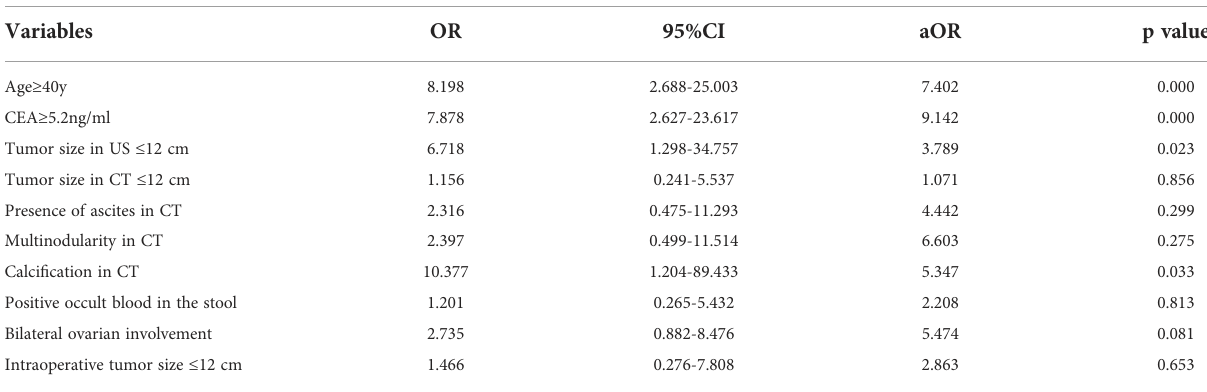
TABLE 3 The predictive factors of the AMNs were evaluated by multivariate analysis. Logistic regression analysis